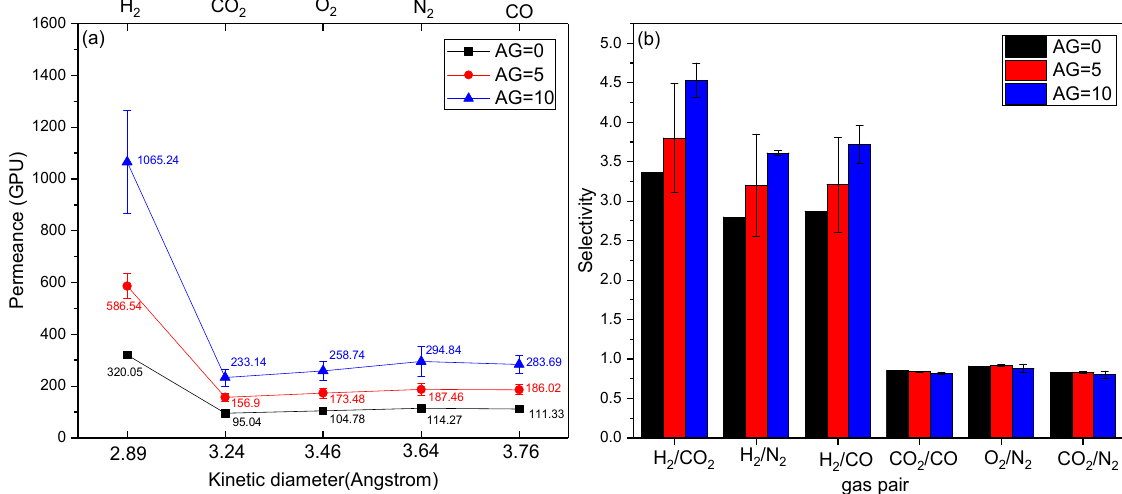
Figure 4. Effect of the air gap distance on ( a ) gas permeance and ( b ) selectivity of the as-obtained MMHFMs (used filler size: 1000 nm; flow rate ratio: 5.14).